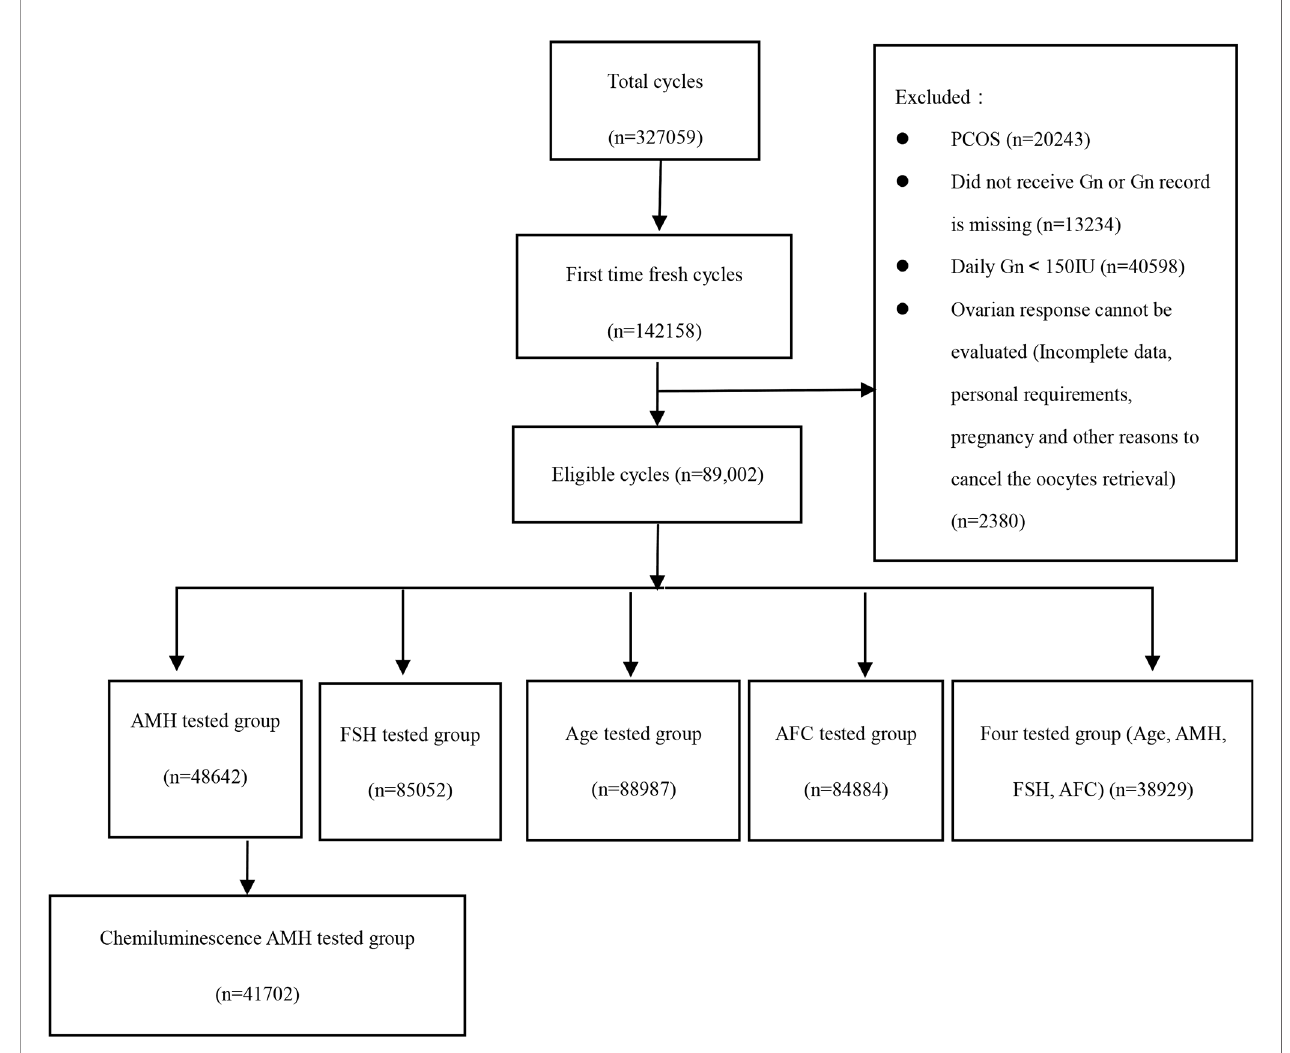
FIGURE 1 | The data